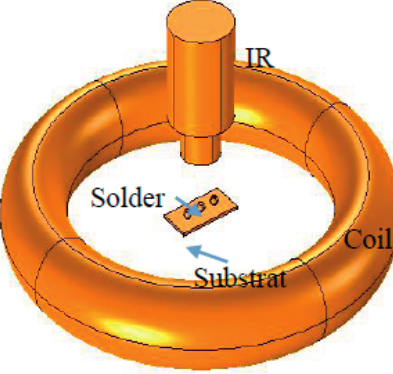
Figure 1. The schematic diagram of pulsed eddy current